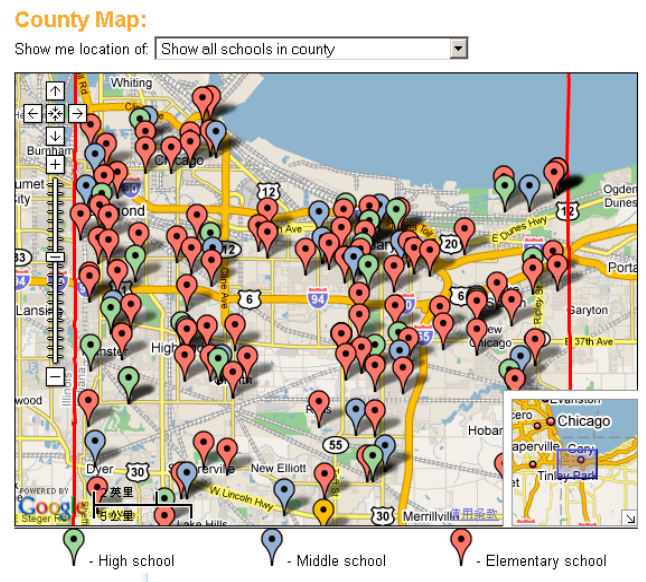
Figure 1. Locations of schools near major highways in Lake County, IN.